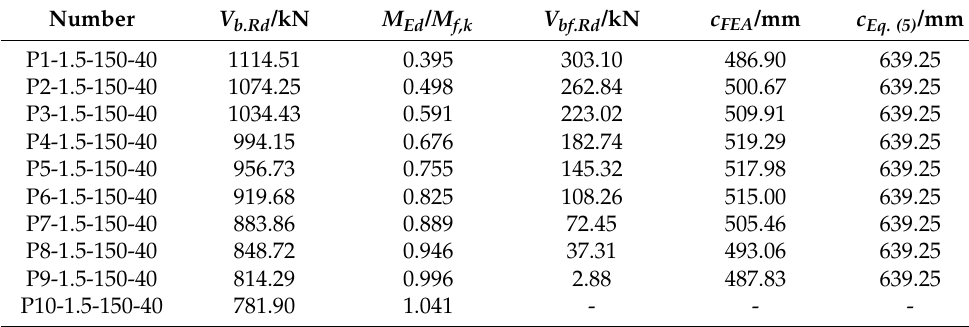
Figure 17. FEA results of S600E sorbite SS plate girders under the different bending moments and shear loadings. Table 4. Numerical results for S600E sorbite SS plate girders: 1.5-150-40.